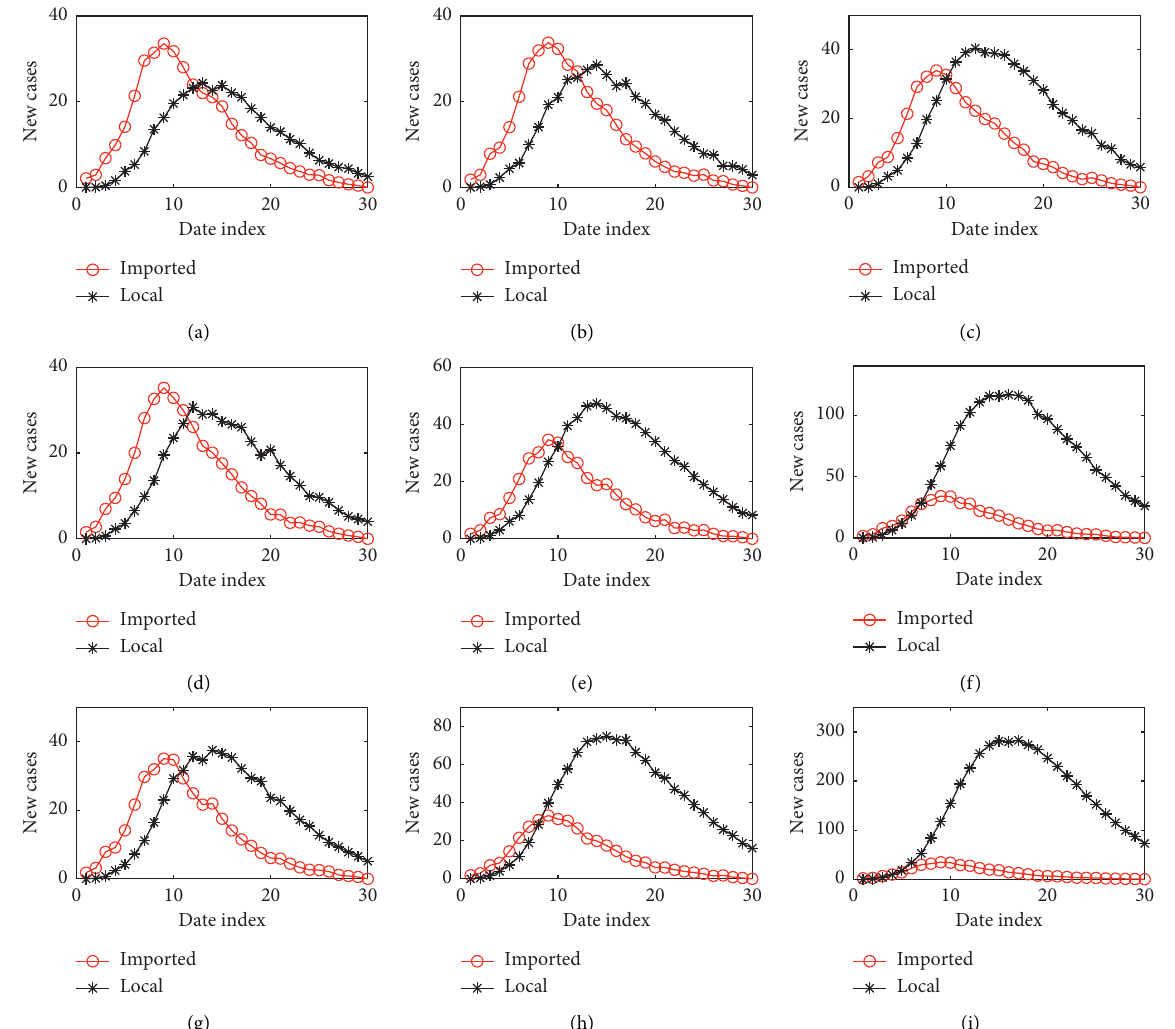
Figure 6: The simulation results of the age-dependent branching process with immigration. The red and black curves are for the imported and local cases, respectively. The red curves in all the subfigures are simulated with the same rate r ( t ) , as shown in Figure 5. The black curves are the number of local cases with different combinations of the values for the testing parameters as α � 0 . 1 , 0 . 4 , and0 . 7 and λ � 0 . 4 , 1 . 4 , and4 . 8. (a) α � 0.1 and λ � 0.4. (b) α � 0.1 and λ � 1.4. (c) α � 0.1 and λ � 4.8. (d) α � 0.4 and λ � 0.4. (e) α � 0.4 and λ � 1.4. (f) α � 0.4 and λ � 4.8. (g) α � 0.7 and λ � 0.4. (h) α � 0.7 and λ � 1.4. (i) α � 0.7 and λ �